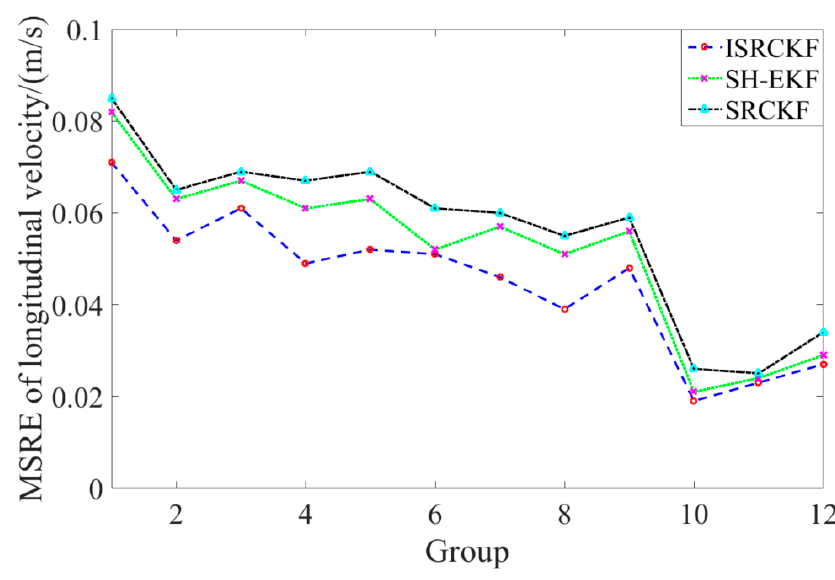
Figure 7. MSRE curves of longitudinal velocity for various filters.